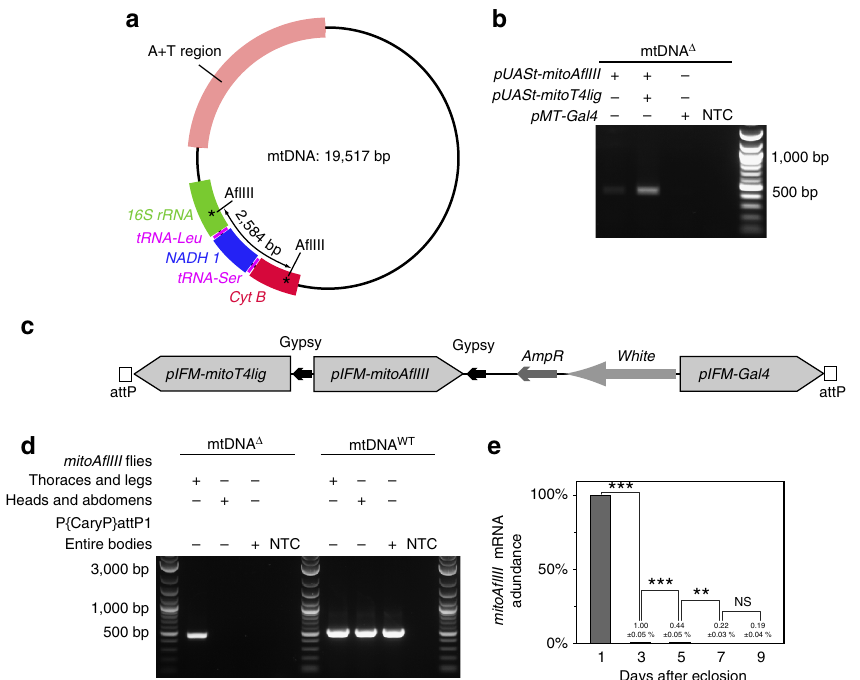
Figure 1 | Engineered heteroplasmy for an mtDNA deletion (mtDNA D ) in Drosophila. ( a ) Map of Drosophila melanogaster mtDNA showing the genes affected following cleavage and re-ligation at two AflIII restriction enzyme cleavage sites. ( b ) Co-expression of mitoAflIII and mitoT4lig in Drosophila S2 cells cause an increase in mtDNA D levels. ( c ) Transgenesis construct for co-expression of mitoAflIII , mitoT4lig and Gal4 under the control of the Flightin indirect flight muscle (IFM)-specific promoter in Drosophila. ( d ) Left panel: mtDNA D is detected by PCR in the thorax, but not the head and abdomen of P{ pIFM-mitoAflIII , pIFM-mitoT4lig , pIFM-Gal4 }attP1 ( mitoAflIII ) flies. mtDNA D is undetectable in P{CaryP}attP1 flies, which were used for a site-specific transgenesis. Right panel: mtDNA WT (the presence of which results in a similarly size band in PCR) is present in all samples other than the no-template control (NTC). ( e ) The abundance of mitoAflIII mRNA falls precipitously after day one post eclosion. Bars depict mean ± 1 s.d. Statistical significance was calculated using Student’s t- test with unequal variance. NS P 4 0.05, ** P o 0.01 and *** P o 0.001. NS, not